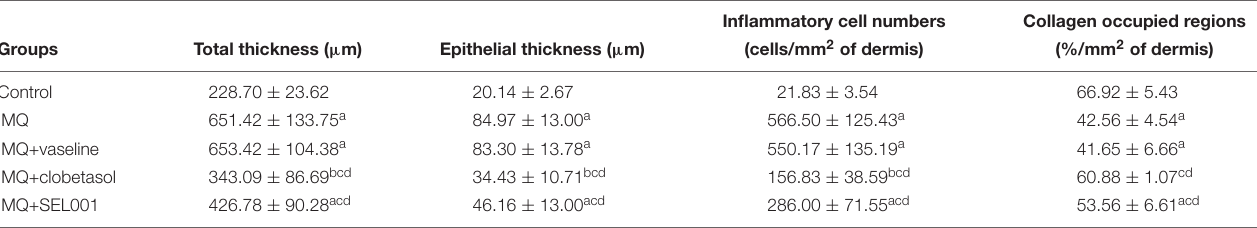
TABLE 1 | Histomorphometrical analysis of ear tissues from control or IMQ-induced psoriasis mice.